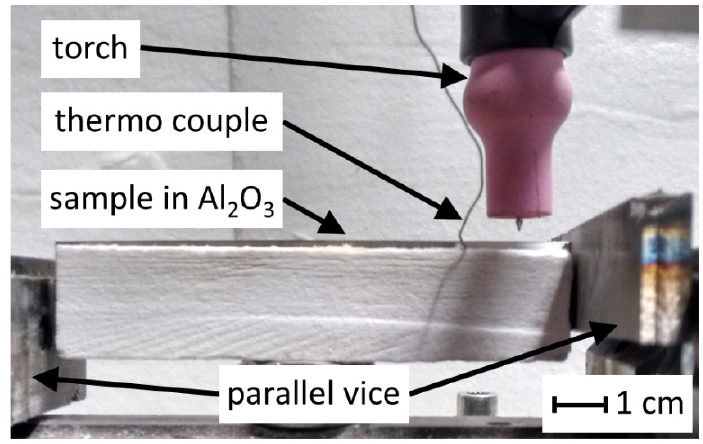
Figure 1. Image of the welding set-up. Direction of view is in neutron flight direction. The sample is fixed edgewise in a parallel vice and is thermally isolated with alumina felt (white). Welding takes place on the long narrow side of the specimen.